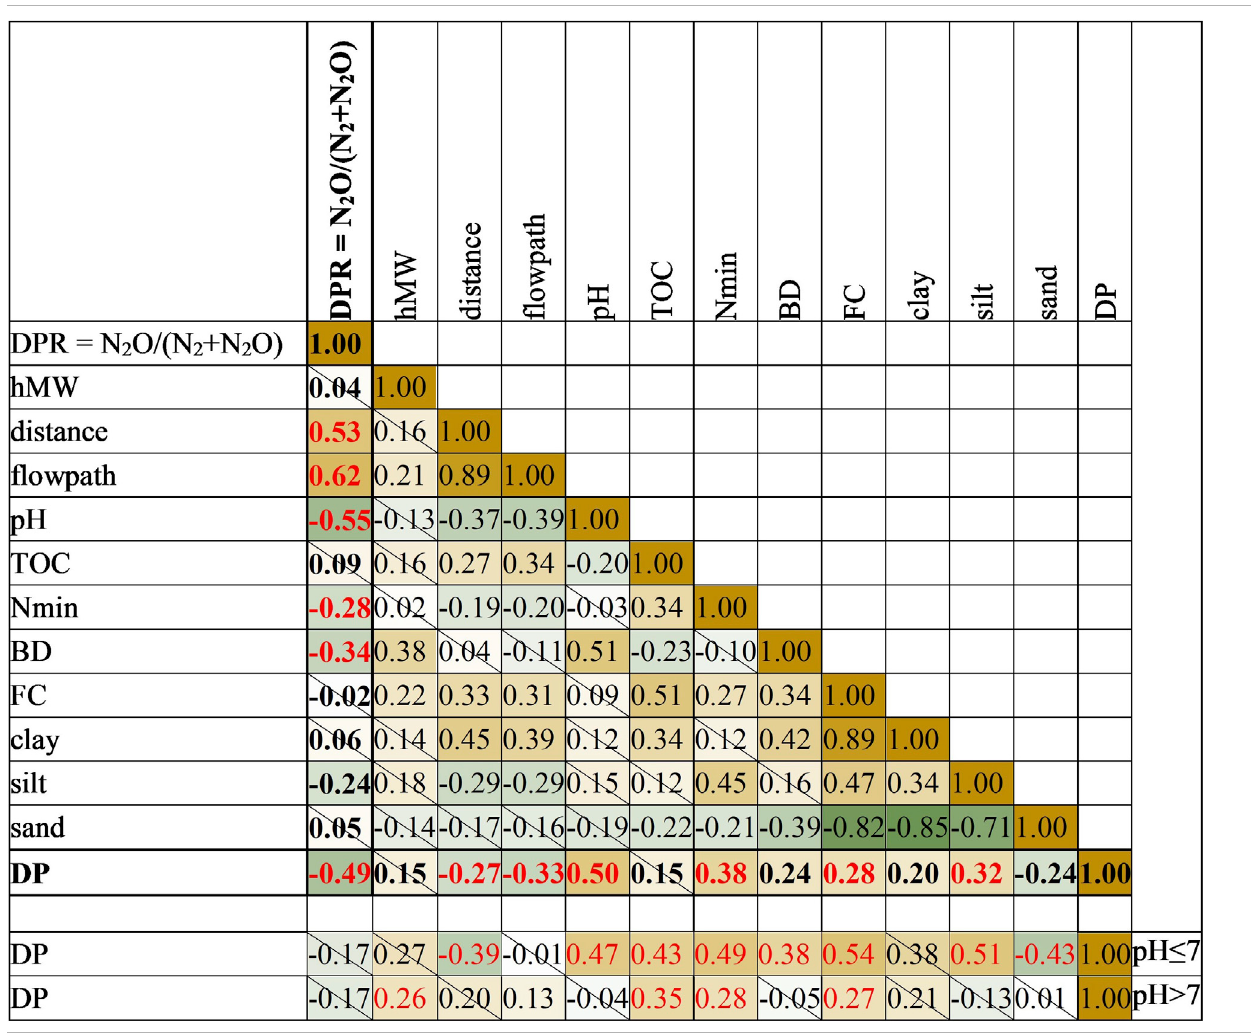
TABLE 3 | Spearman ’ s rank correlation matrix (r spear ) between measured and derived variables. Dark colors indicate stronger absolute correlations. Green indicates negative, brown positive correlations. Cells crossed out are not signi fi cant ( p > 0.05), |r spear | > 0.3 are written in red, n (cid:2) 104.